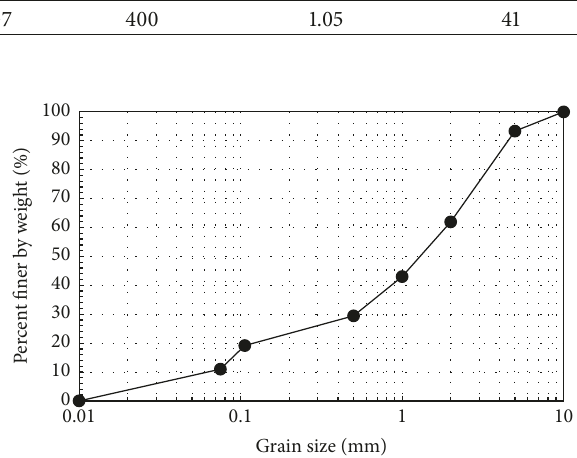
Figure 1: The grain size distribution curve of the expansive